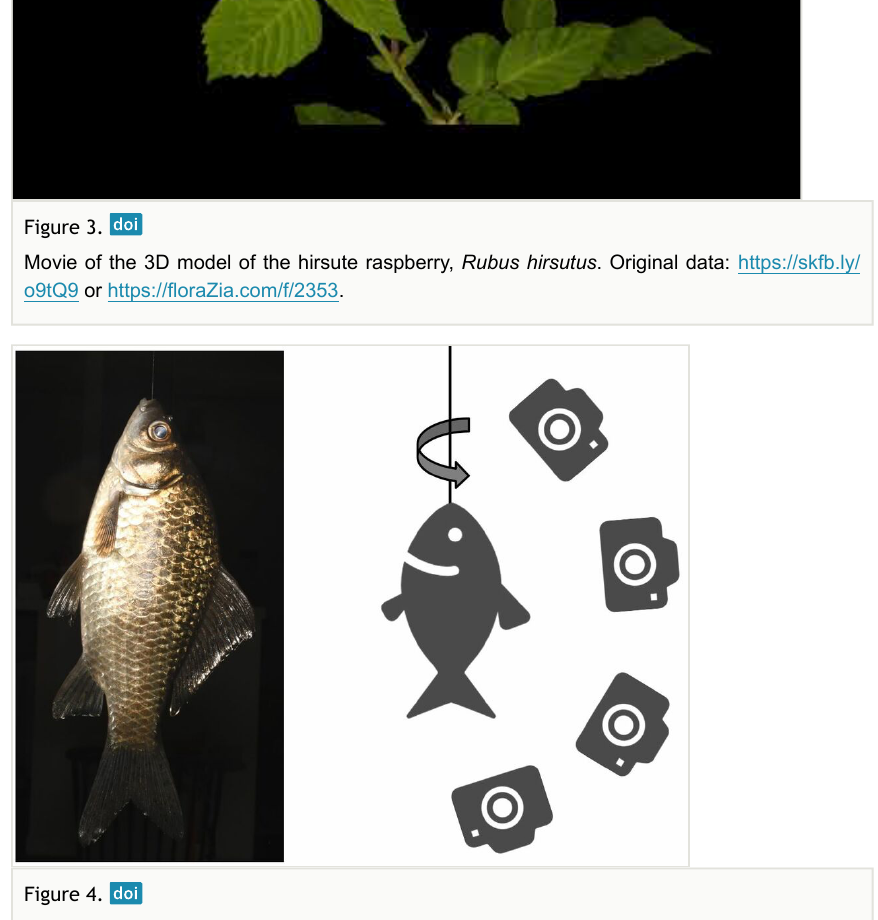
A simplified diagram of the photogrammetry method. The slowly spinning object ( Carassius auratus langsdorfii ), suspended by a nylon fishing line, is photographed from multiple angles. The resulting 3D model is shown at https://skfb.ly/6ZRDz or